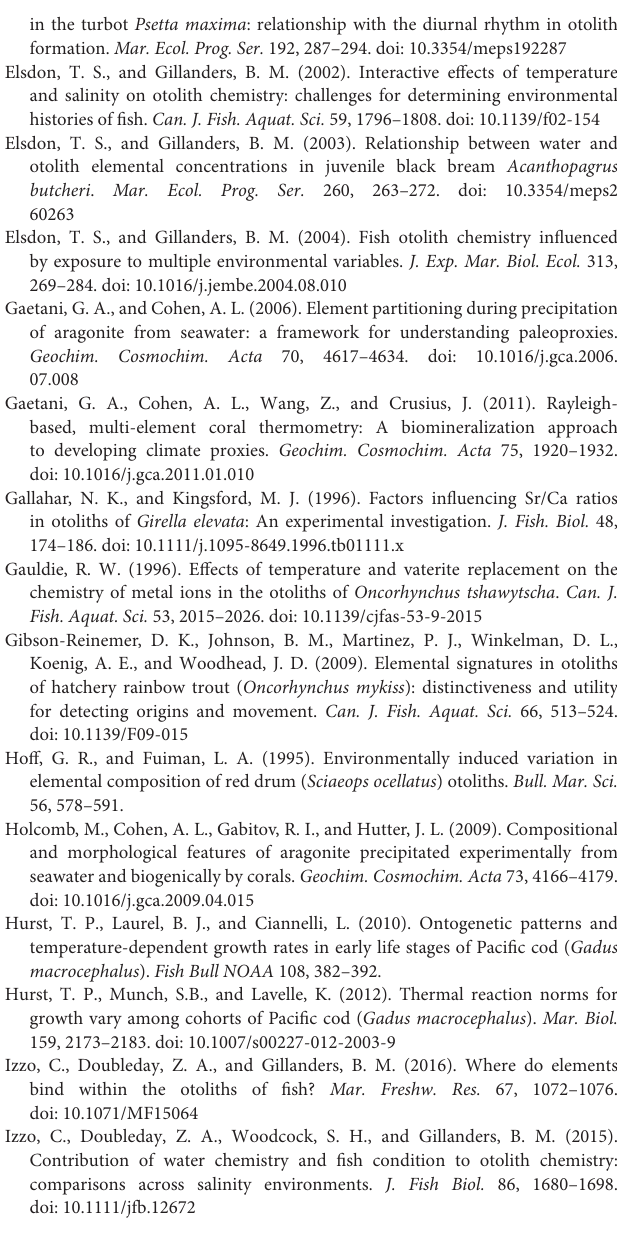
Figure S1 | Scatter plot of D Me and Hepatic Somatic Index (HSI) for all fish in the 2, 5, 9_low ration (9L), 9_high ration (9H), and 13 ◦ C treatments. Figure S2 | Median, first, and third quartiles and outlying points for otolith Me:Ca (upper four graphs) and D Me (lower four graphs) for each tank. Axis labels indicate the temperature followed by the tank number (e.g., 2.1 = 2 ◦ C treatment, tank 1).